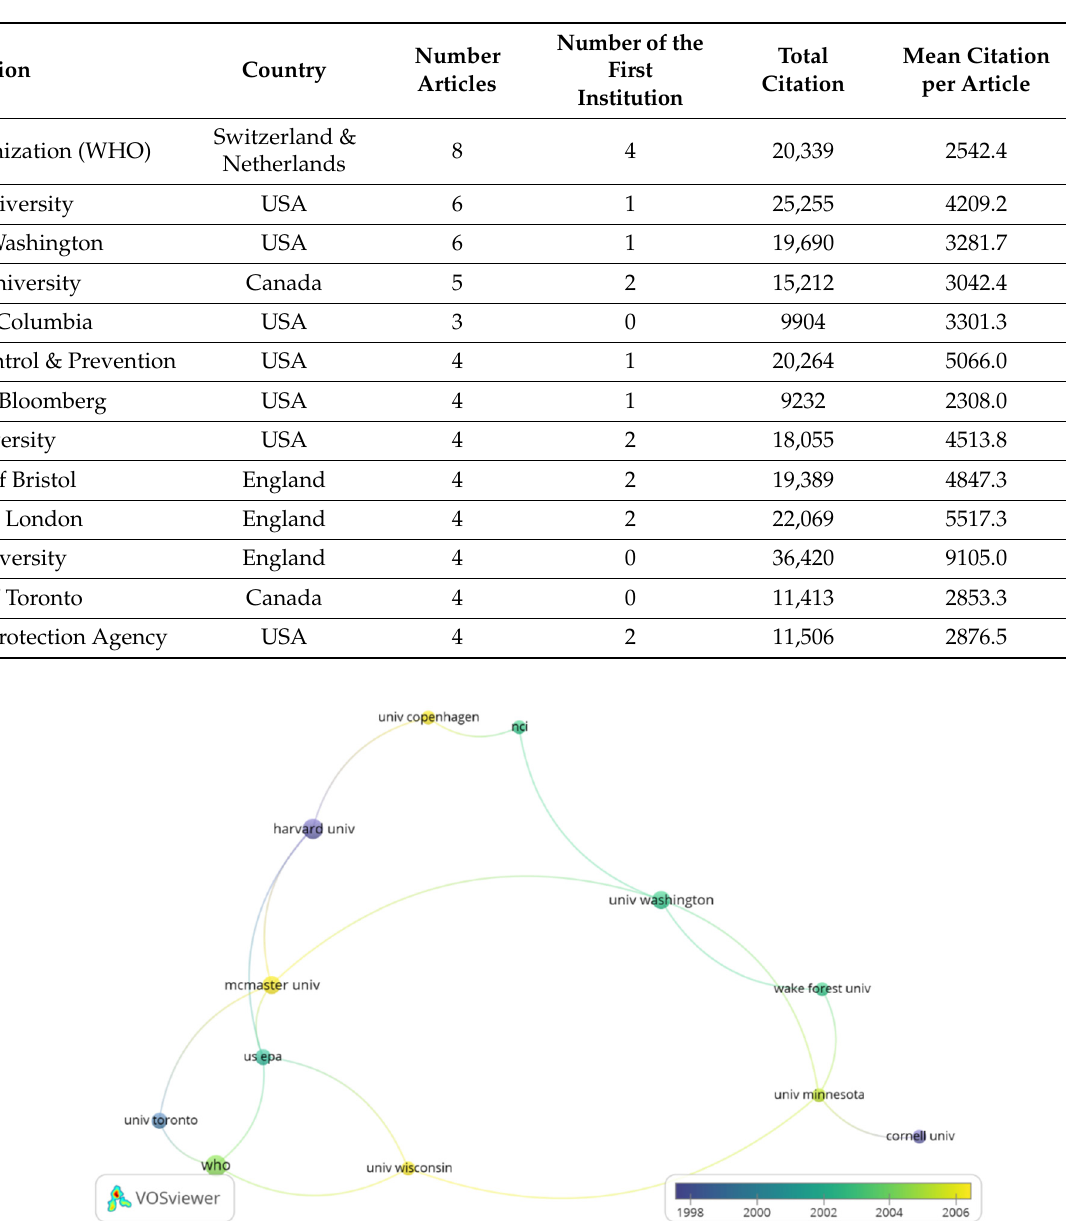
Table 4. The top institutions with the most highly cited articles.